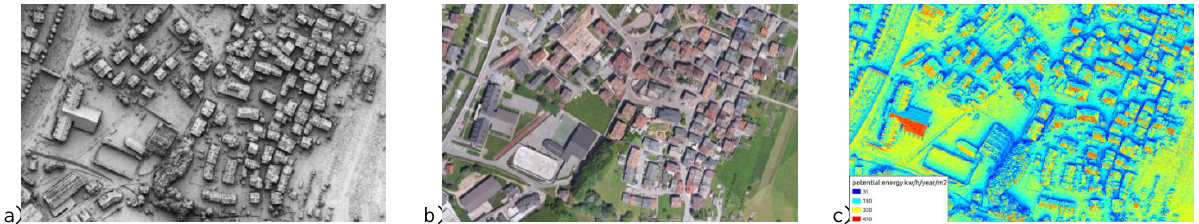
Figure 1. Results of the photogrammetric DSM generation from aerial images (a), true orthophoto (b) and solar potential energy estimation visualized with the raster-based webGIS tool created within the 3DSolarWeb project